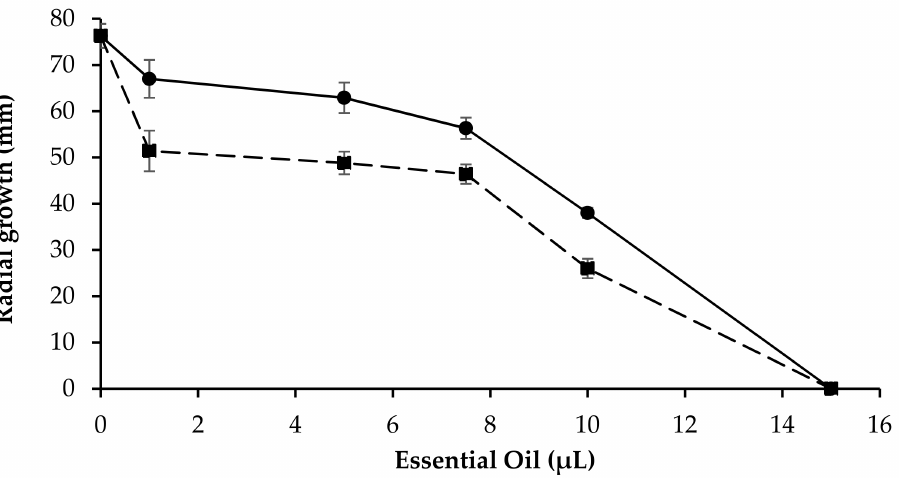
Figure 9. Scavenging effect of the two different essential oils of L. augustifolia , LA 2019 ( ● ) and LA 2020 ( ▪ ) on ABTS assays at different concentrations ranging from 0.041 mg/mL to 8.5 mg/mL. Data are expressed as mean values ± SE ( n =